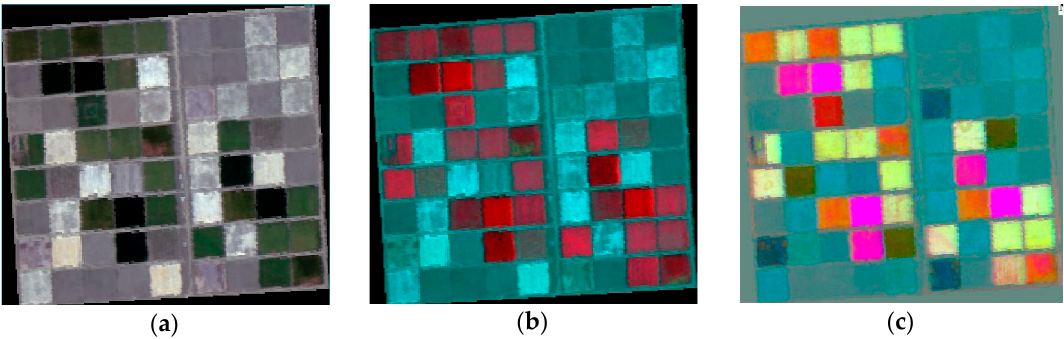
Figure 7. ( a ) True color composite; ( b ) False color composite; and ( c ) Color composite of the first three components of the maximum noise fraction (MNF) transformation.